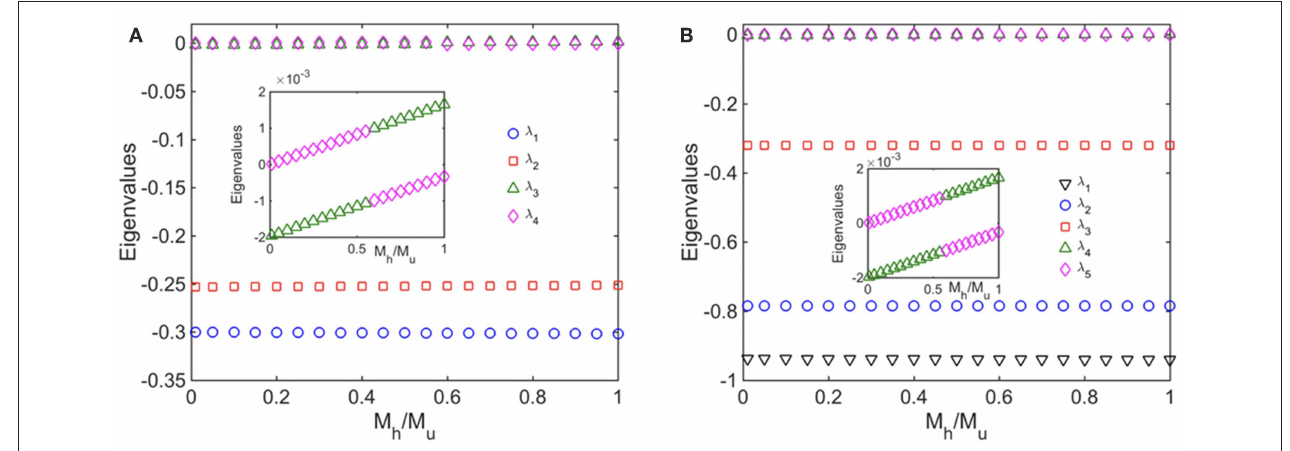
FIGURE 6 | Linear Stability analyses (A) without ATP, and (B) with ATP dependence taken into account; in (B) all mitochondria produce ATP at the same rate. The figures show the eigenvalues of the Jacobian matrix as a function the ratio of the mitophagy rates of healthy and unhealthy mitochondria. We have set λ h 0 =